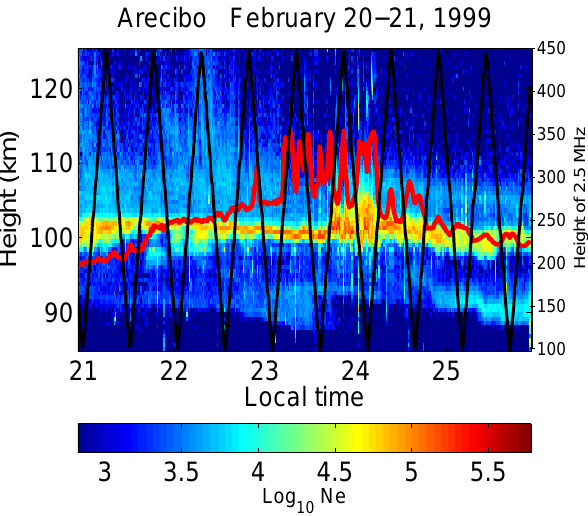
position shown as in the previous figure. The right-hand axis refers to the heavy red line showing the height of the 2.5MHz contour following the bottomside of the F region. This 2.5MHz contour is also highlighted in Fig. 1. (Adapted from Fig. 12 of Swartz et al.